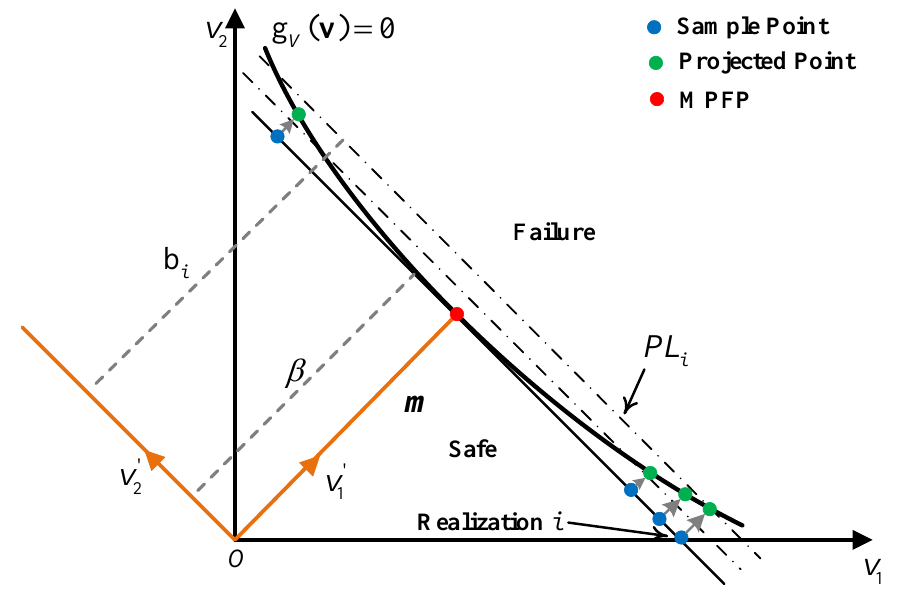
Figure 1. Axis orthogonal importance Latin hypercube sampling method.